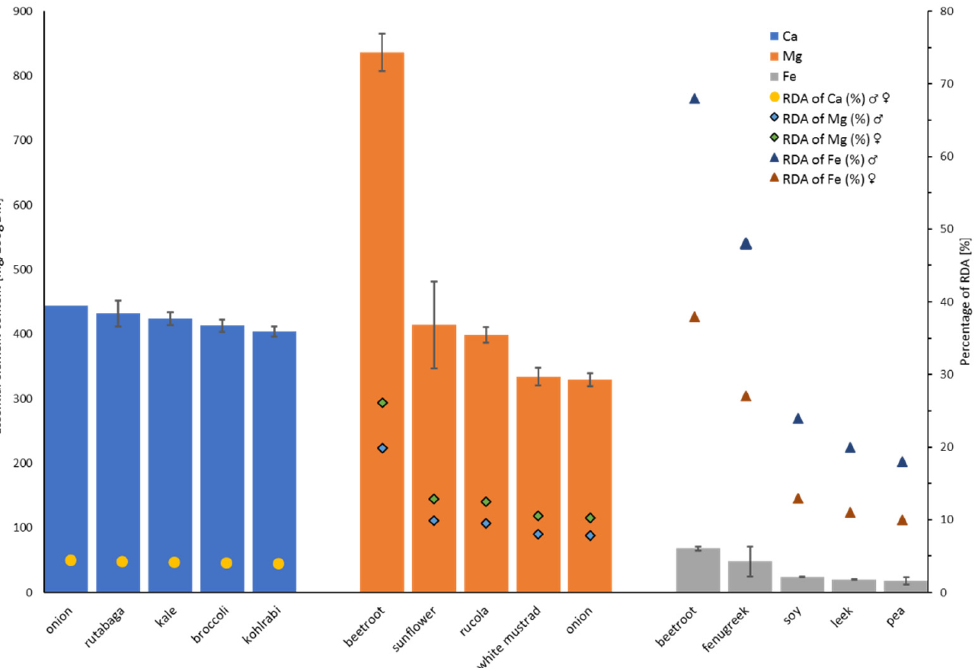
Figure 2. The concentration of essential minerals and iron in the sprouts from the top five groups (see explanation in the text above), with the reference to % of RDA* through consumption of 100 g of fresh sprouts. *% of Recommended daily allowance (RDA) based on human nutrition standards for the Polish population [41]. RDA for Ca for males (31–50 years) and females (31–50 years) is 1000 mg/day/person; RDA for Mg for males (31–50 years) is 420 mg/day/person and for females (31–50 years) is 320 mg/day/person; RDA for Fe for males (31–50 years) is 10 mg/day/person and for females (31–50 years) is 18 mg/day/person.